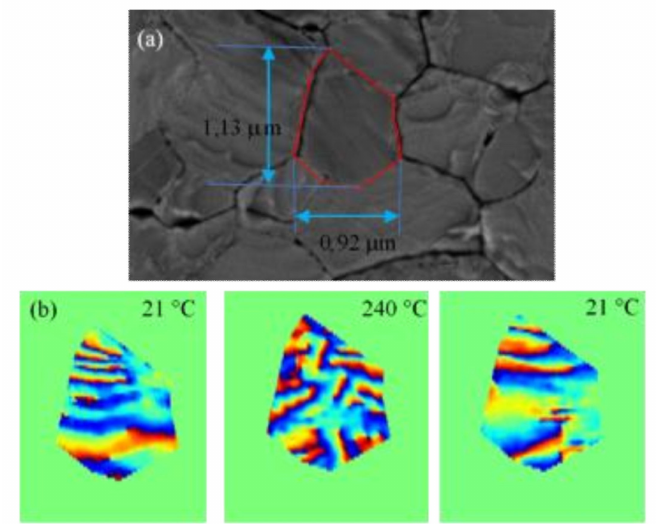
Figure 7. ( a ) Scanning electron microscopy image of a polycrystalline gold film; the measured grain is indicated in red. ( b ) Mid-height section of the displacement field as a function of temperature [83]. Reprinted from [83].